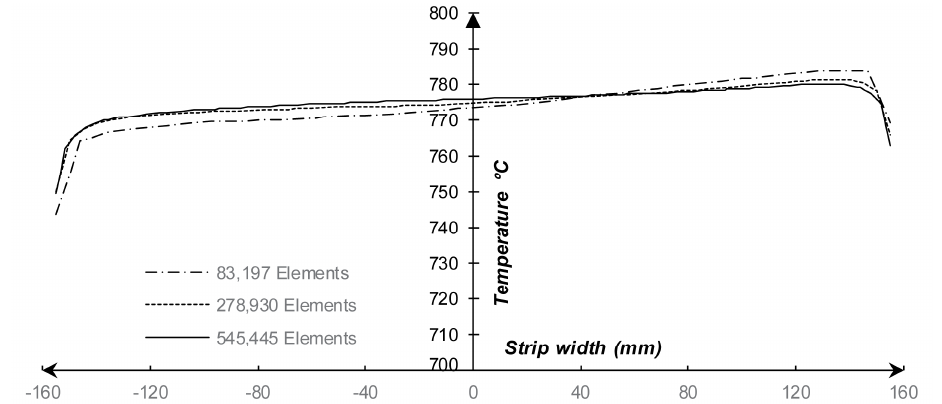
Figure 4. The results of the model verification by temperature predictions across the width of strip.